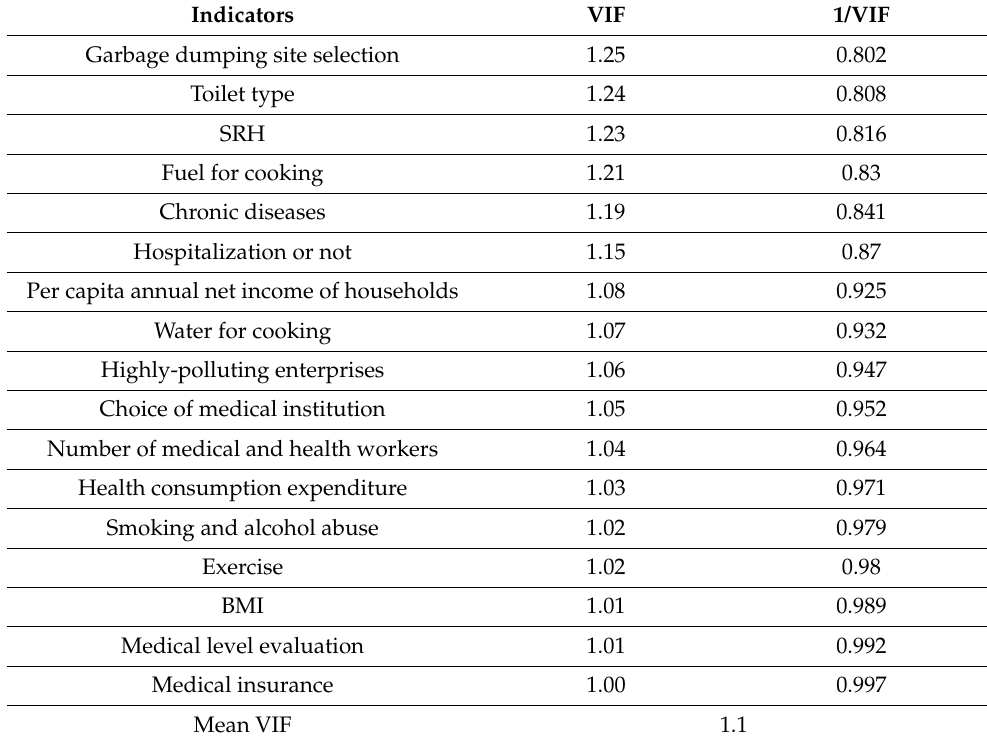
Table 2. Collinearity assessment